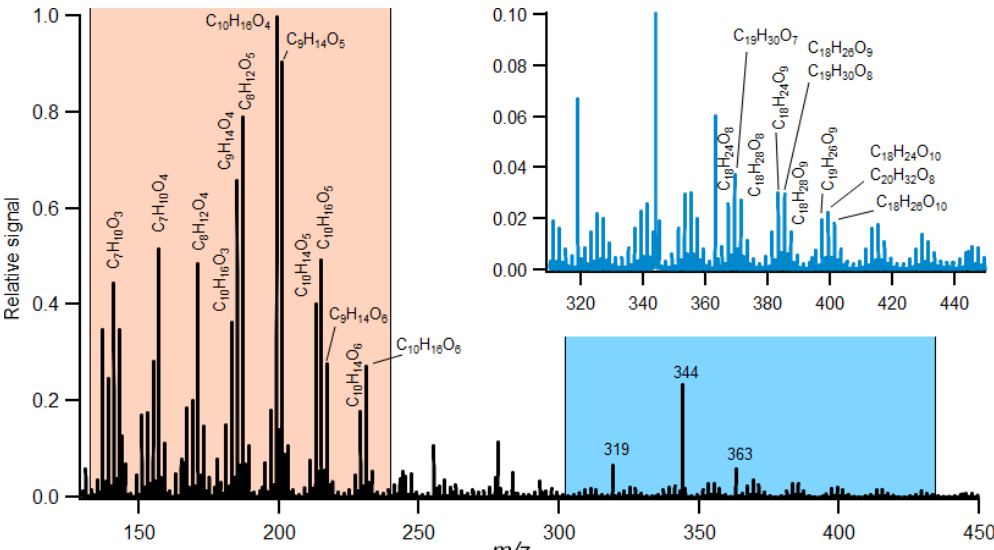
Figure 2. Example of derived mass spectra of the condensed phase taken from the experiment (Experiment no. 21) with medium-ozone and high-limonene conditions with added OH scavenger. The regions with identified monomers (orange region) and selected dimers (blue region) are indicated. The peaks at 319, 344 and 363 are associated with the HPFA used for mass calibration. The complexity of this mass spectra is described using the fraction of 10 dominant product ions, and the spectra are compared to other experiments with similar conditions in Fig.